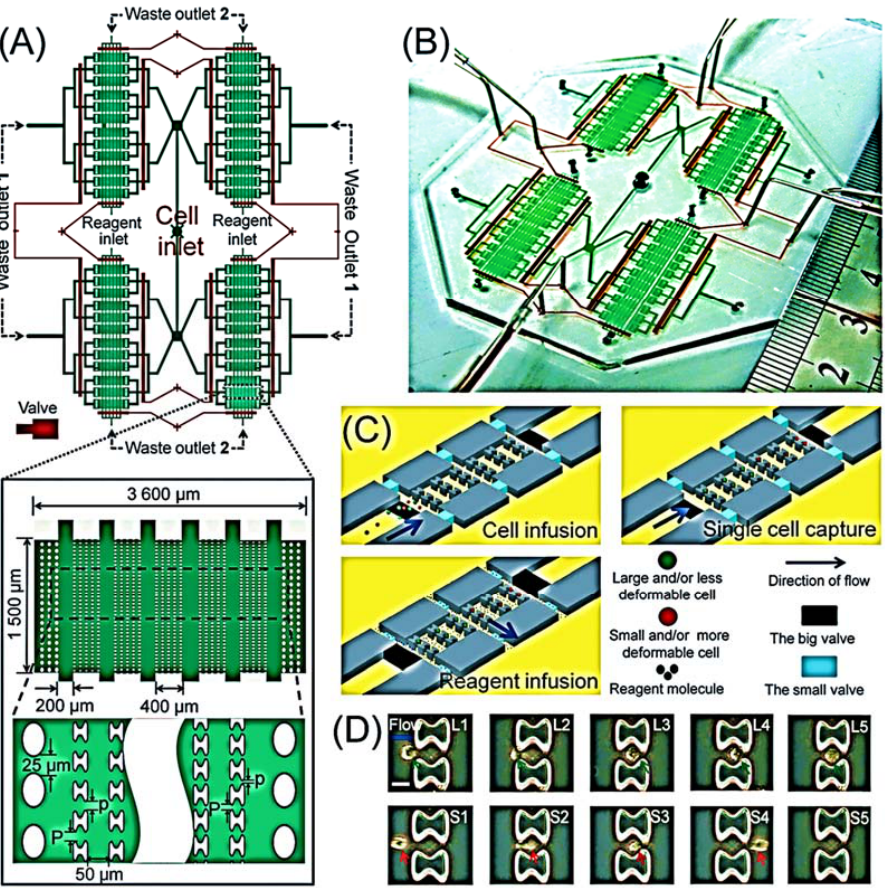
Figure 3. Schematic diagram of the Microfluidic chip for obtaining single cells: ( A ) Schematic diagram of the design of the Microfluidic chip. ( B ) Actual image of the Microfluidic chip, measuring 6.0 cm × 5.0 cm. ( C ) Schematic diagram of the operation of single cell sorting and reagent infusion. ( D ) Schematic diagram of the typical dynamic processes of single cells captured by (L1–L5) or passed through (S1–S5) filter cells. The image from [39], Copyright 2016, Royal Society of Chemistry.